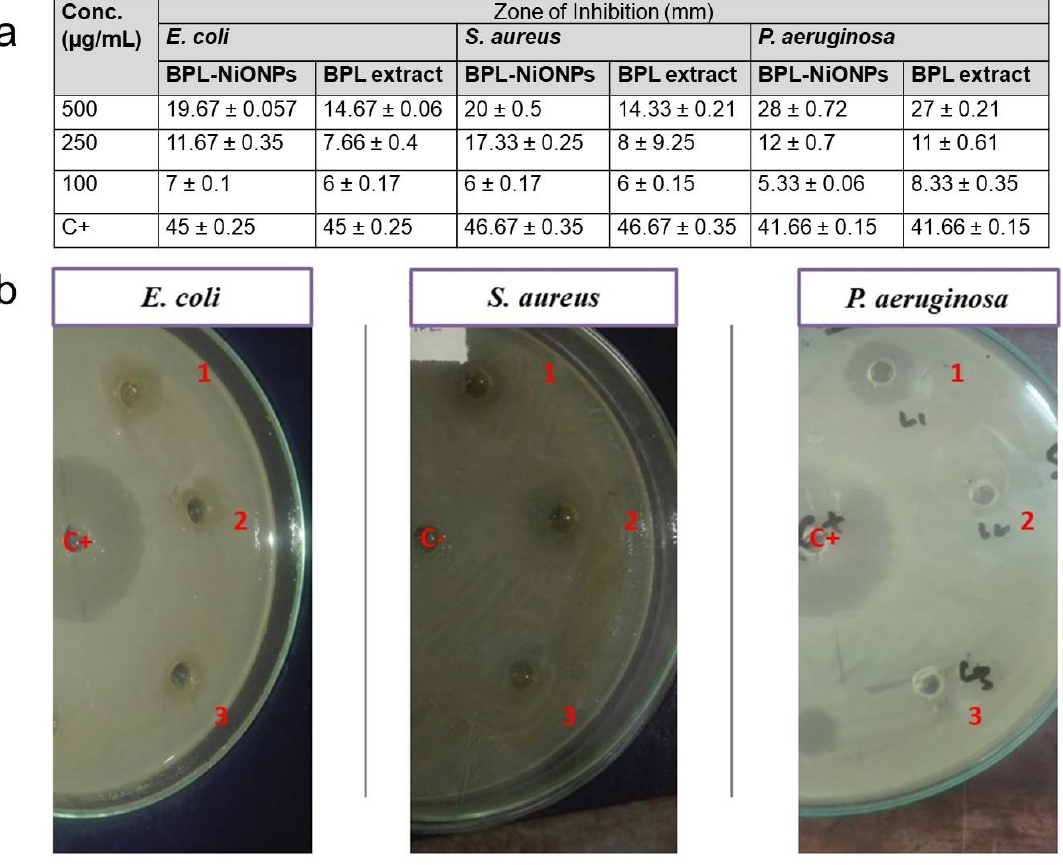
Figure 5. Antibacterial activity of BPL-NiONPs against E. coli , S. aureus and P. aeruginosa. ( a ) Zone of inhibition against 500, 250 and 100 µg/mL; ( b ) The clear inhibited area of tested pathogens at 500, 250 and 100 µg/mL of BPL-NiONPs. The obtained data are presented as mean ± standard deviation ( n = 3). The numbers: 1, 2 and 3 represent the concentration of BPL@NiONPs (500, 250 and 100 µg/mL), while C+ and C − refer to the positive (Kanamycin) and negative control (distilled water), respectively.